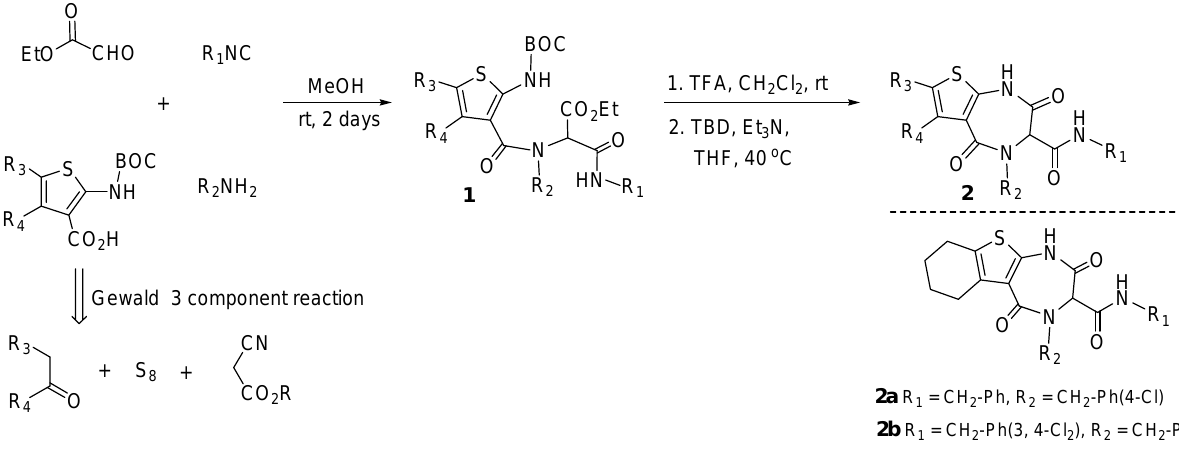
Figure 3. Application of an Ugi-4CR in the discovery of p53-Mdm2